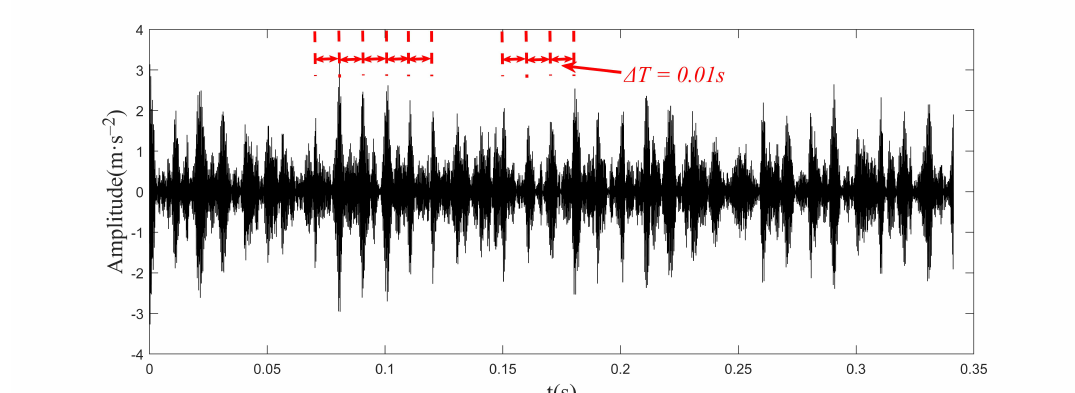
Figure 7. Time domain waveform x (cid:48) ( t ) after the weighted reconstruction of the simulated signal of the rolling bearing outer ring fault.